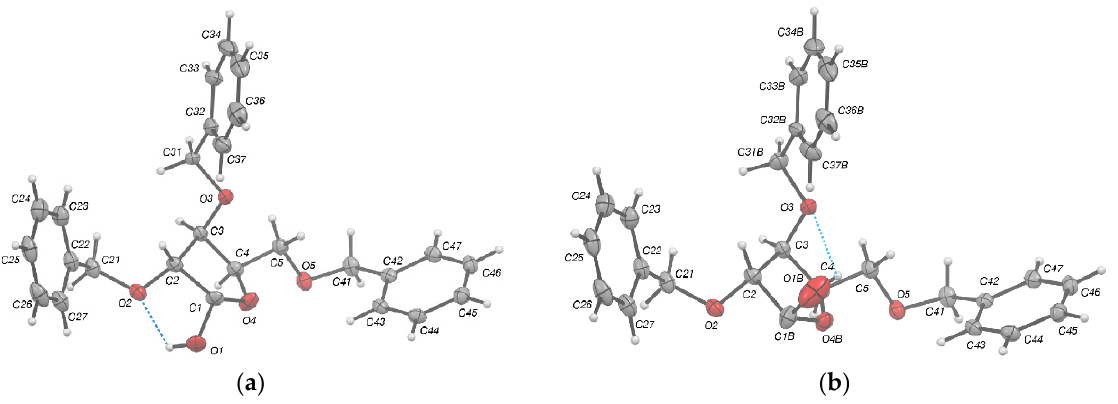
Figure 1. ( a ) Molecular structure of ( α )- 1 with numbering scheme and anisotropic displacement ellipsoids drawn at the 50% probability level, hydrogen atoms being represented by spheres of arbitrary radius; ( b ) Ortep view of the minor ( β )- 1 compound. Dotted line in cyan highlights the intramolecular h-bond.